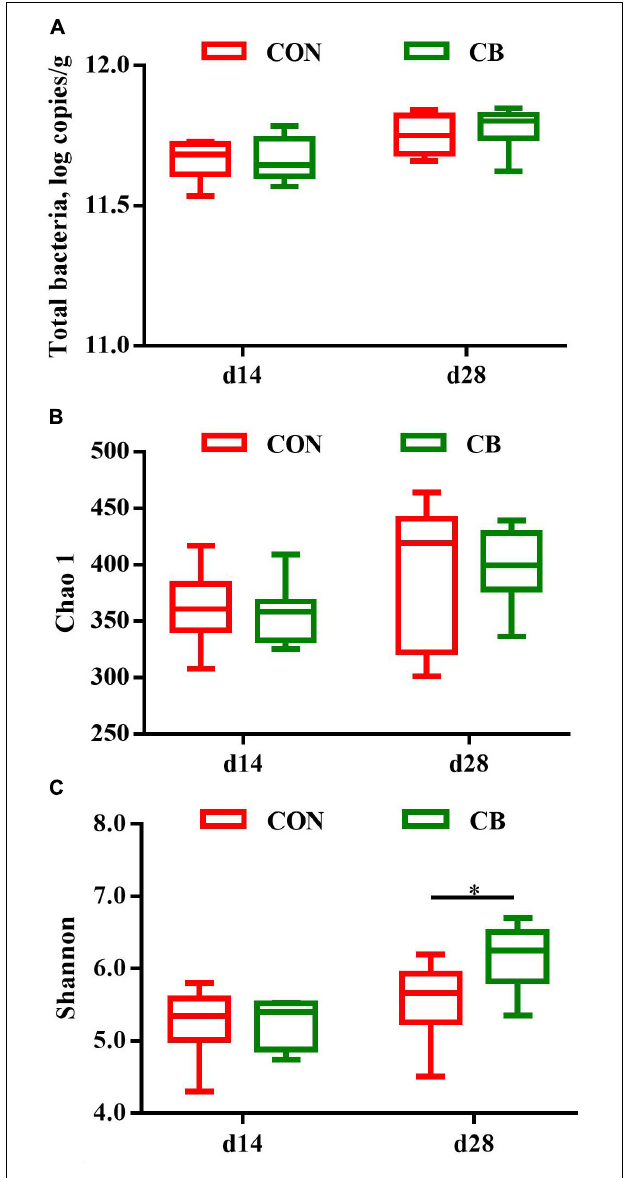
FIGURE 1 | Effects of dietary corn bran on the richness and diversity of microbial communities in weaned pigs. (A) Total bacterial load on days 14 and 28. (B) Chao 1 index of bacterial community on days 14 and 28. (C) Shannon index of bacterial community on days 14 and 28. Gut microbiota composition in feces ( n = 6 per treatment) were determined by 16S rRNA amplicon sequencing on the trial of days 14 and 28. The results were analyzed